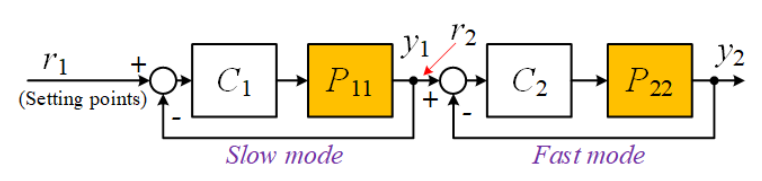
Figure 4. Fast mode output following the slow